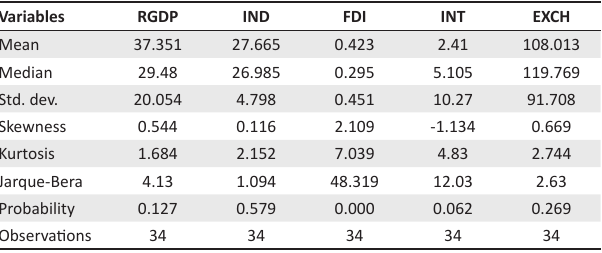
TABLE 1: Descriptive statistics.